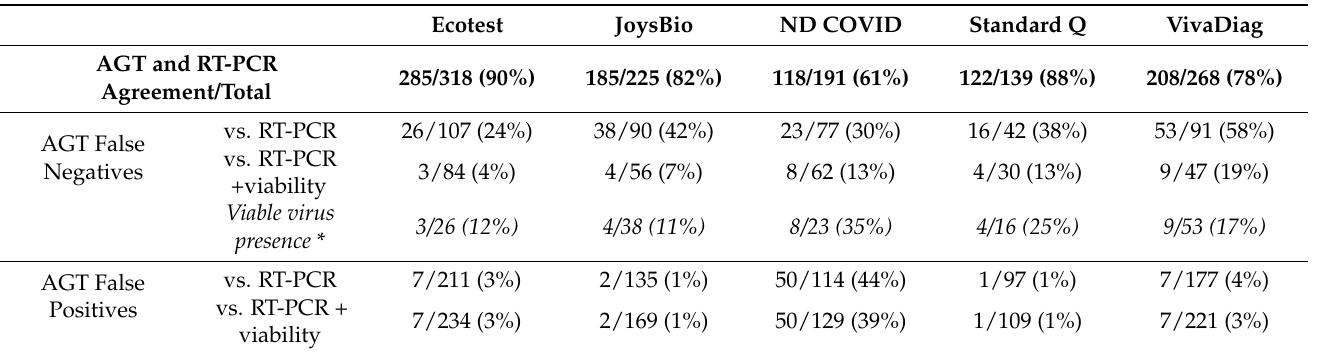
Table 2. Agreement between the antigen tests (AGT) and RT-PCR, false negative and false positive samples out of the total number of positive/negative samples according to the particular reference method (RT-PCR or RT-PCR + virus viability).